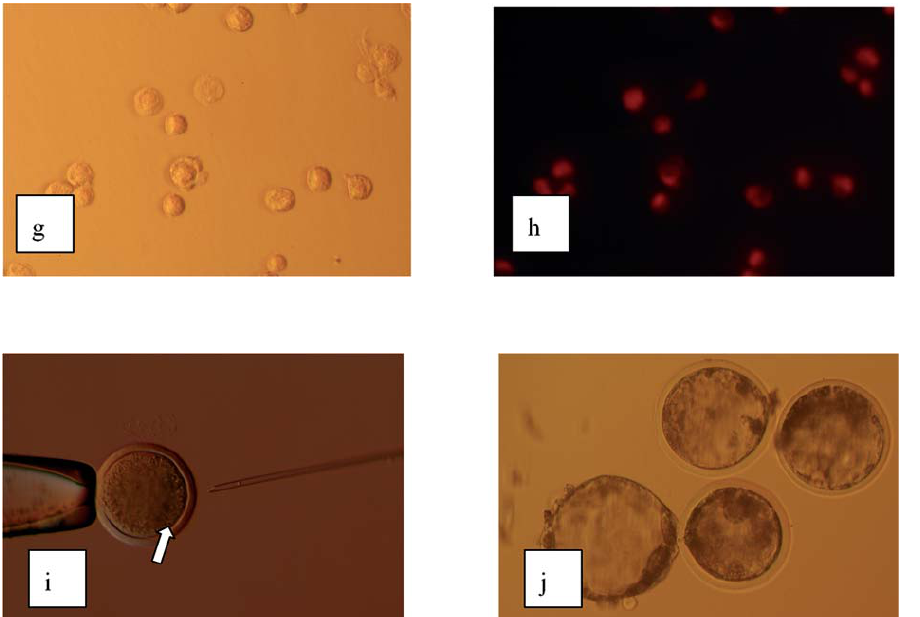
Figure 2. g–h, re-hydrated granulosa cells Propidium Iodine staining (g, bright field; h, epifluorescence) 6 150. i, nuclear transfer of freeze-dried granulosa cell 6 60. j, blastocyst produced from nuclear transfer of freeze dried granulosa cells 6 40.